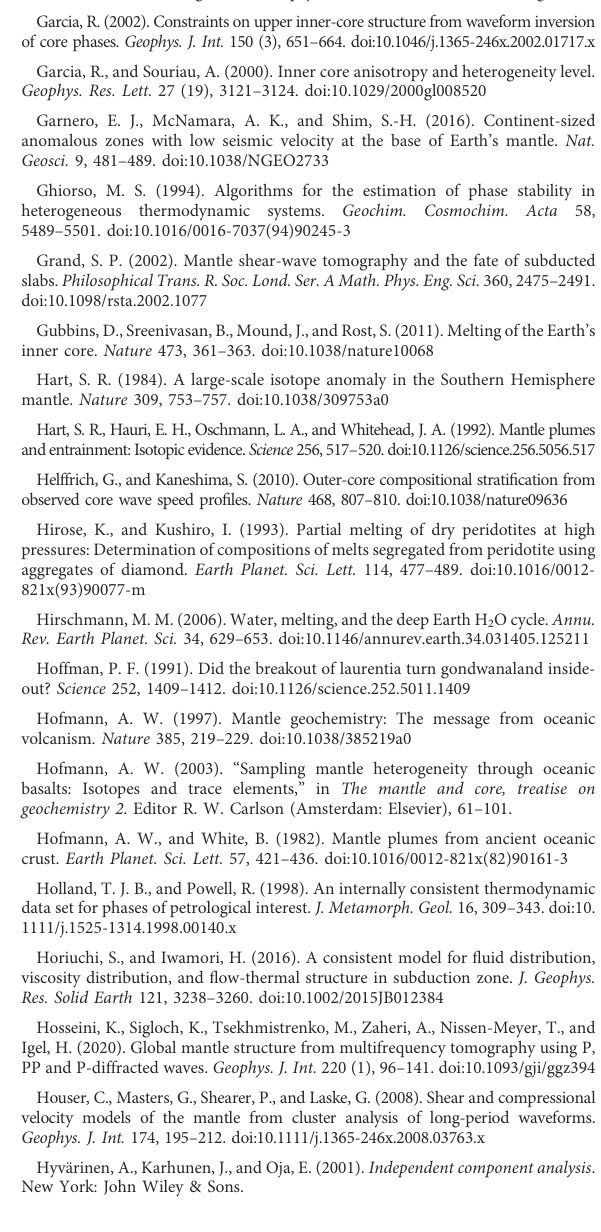
Figure 1A was illustrated through the SubMachine web portal